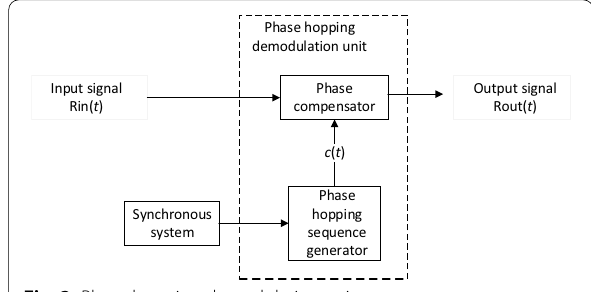
Fig. 2 Phase hopping demodulation